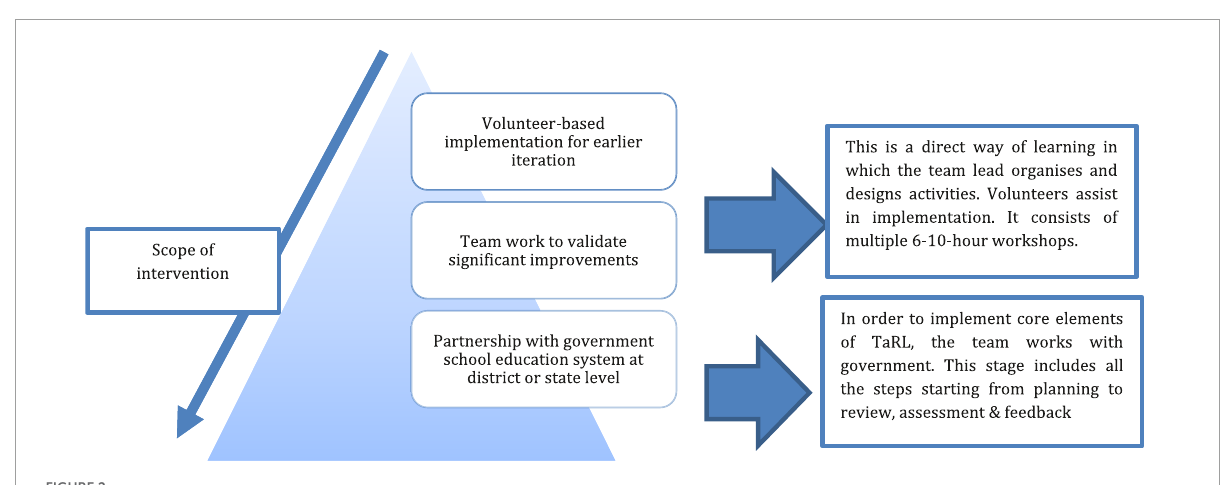
FIGURE2 Implementing